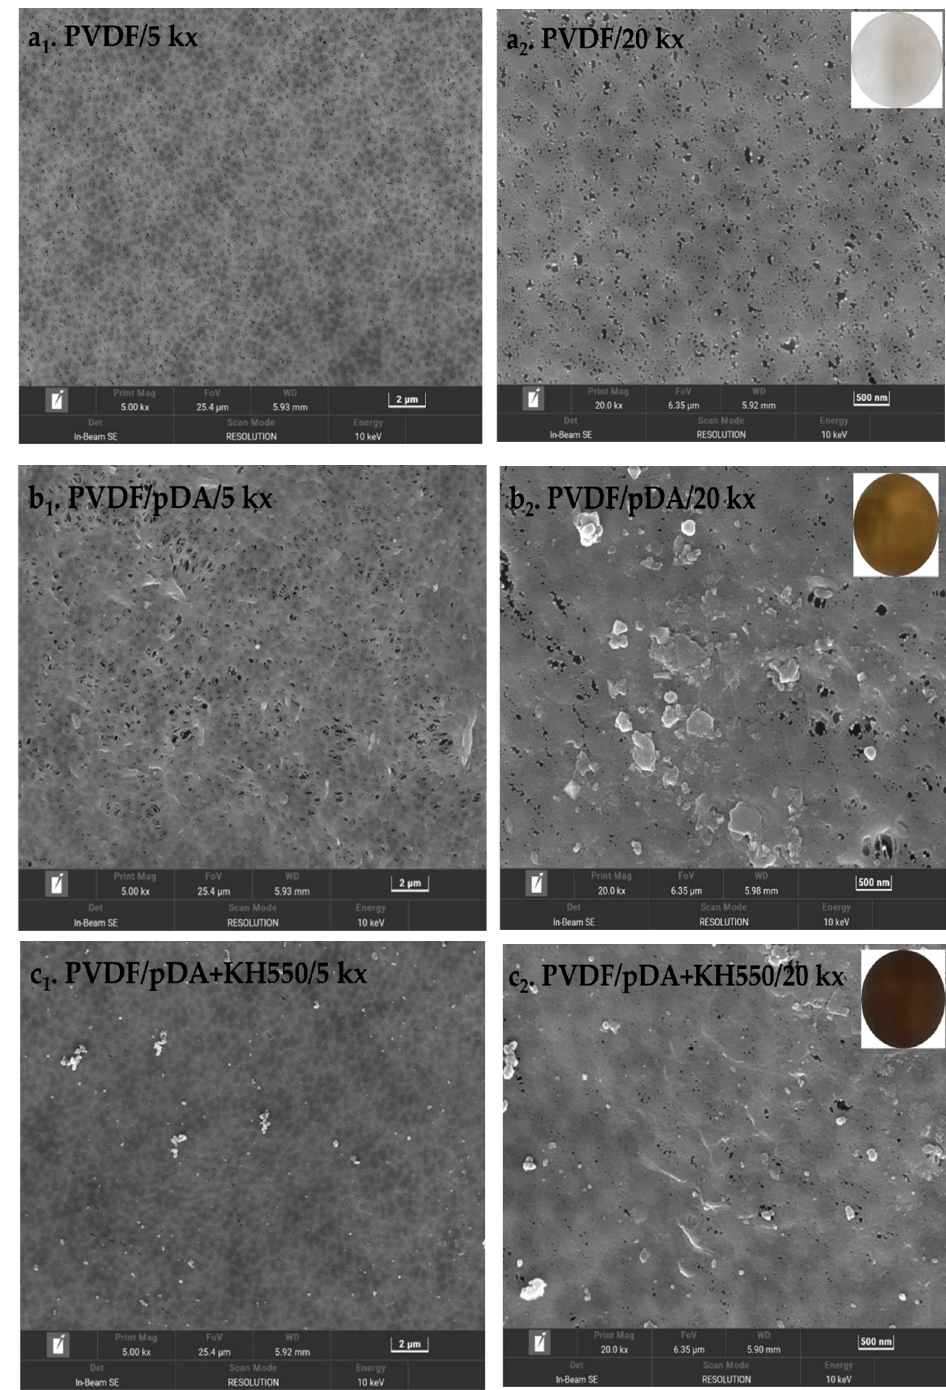
Figure 2. The SEM and pictures of the top surface morphologies of pristine and coated membranes ( a 1 – c 1 ): low-resolution images (5 kx), ( a 2 – c 2 ): high-resolution images (20 kx)).